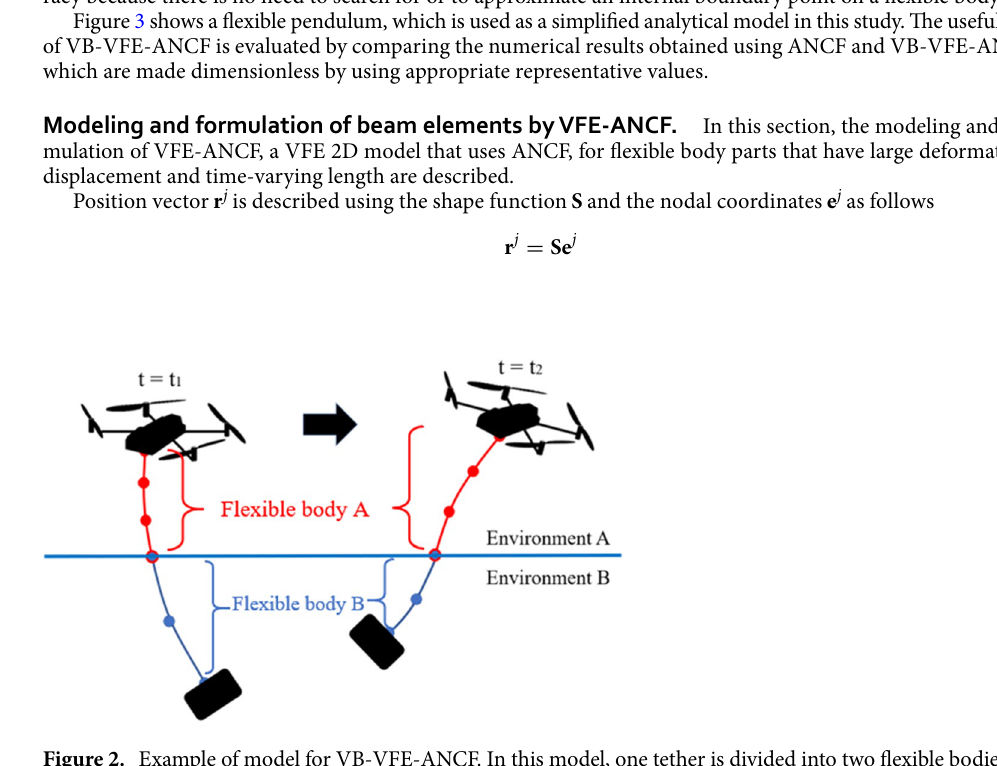
Figure 2. Example of model for VB-VFE-ANCF. In this model, one tether is divided into two flexible bodies, A and B, depending on the environments in which they exist. As a result, the internal boundary position is always at the connected point of flexible bodies A and